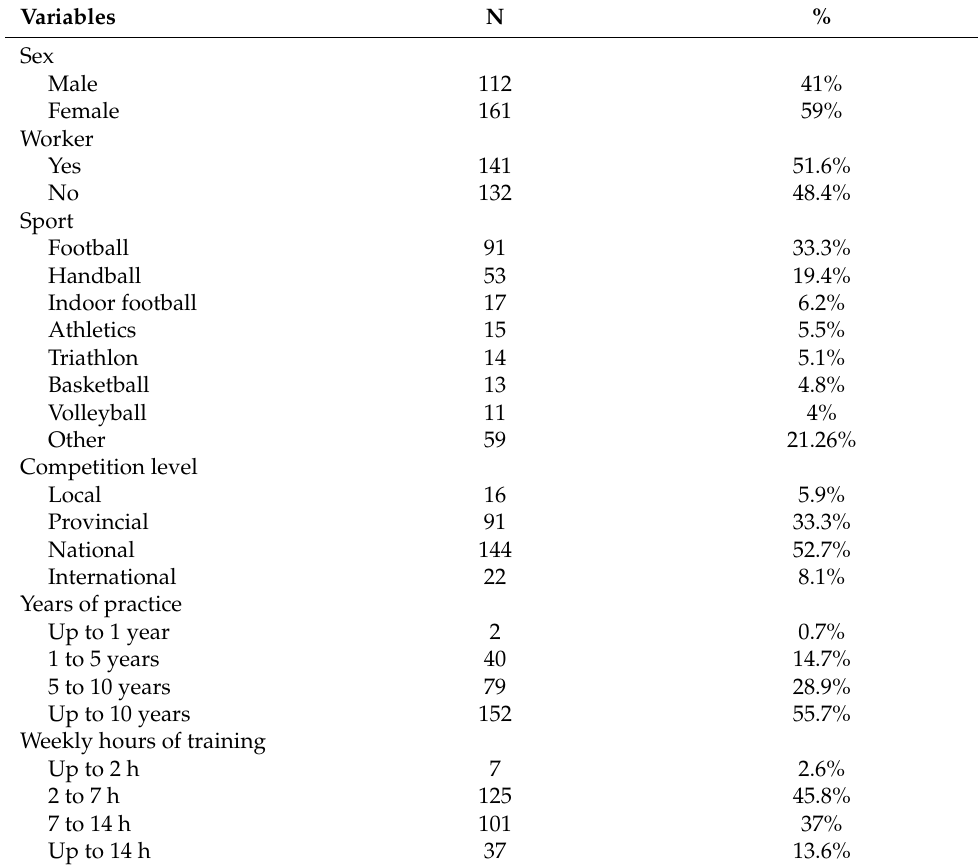
Table 1. Characteristic of the study